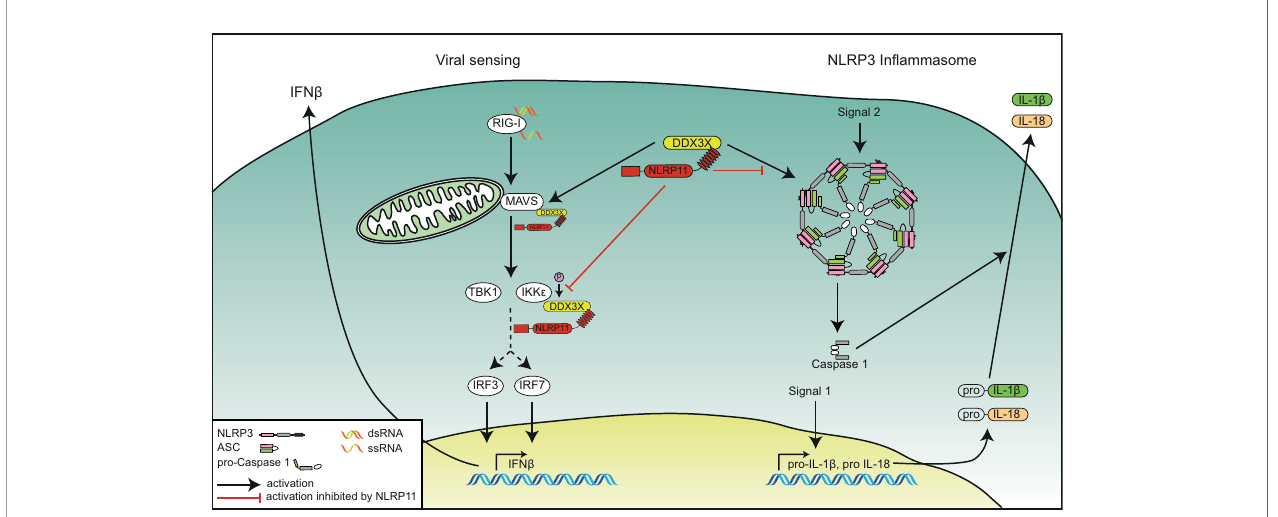
FIGURE 5 | Schematic overview of the functional interplay of DDX3X and NLRP11 in innate immunity. The role of NLRP11 in attenuating RIG-I-induced type I interferon responses (left side) and in the activation of the NLRP3 in fl ammasome (right side) is depicted. NLRP11 interacts with DDX3X via its LRR domain. NLRP11 reduces type I interferon responses downstream of RIG-I activation by negative regulation of the activity of DDX3X in type I interferon induction. NLRP11 can also interfere with DDX3X-mediated NLRP3 in fl ammasome activation, leading to reduced IL-1 b